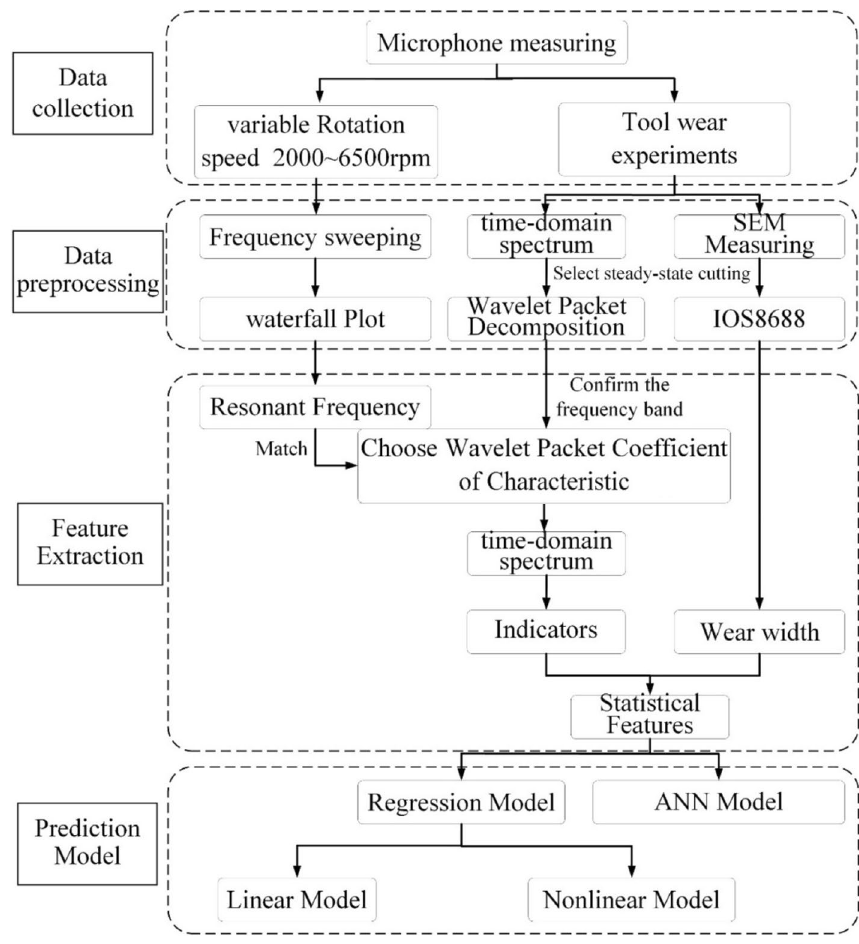
Fig. 6 Tool wear monitoring process based on sound signal